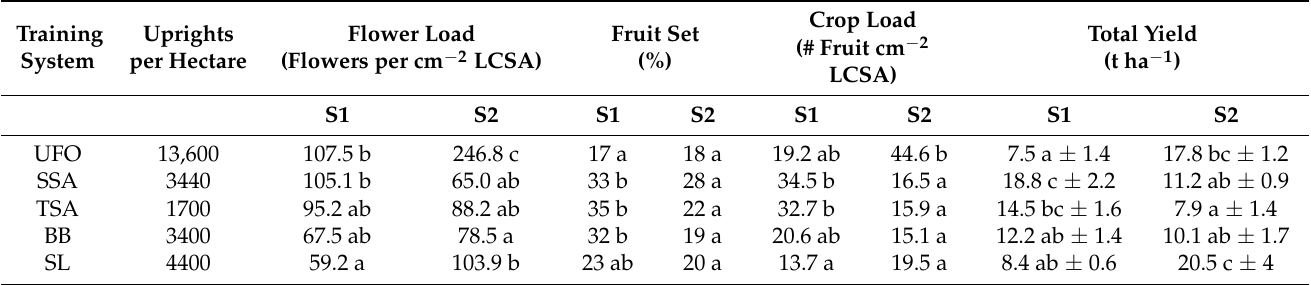
Table 4. Flower load, fruit set, crop load and yields of sweet cherry cv. ‘Kordia’ on multiple training systems for the first (2019–2020) and second (2020–2021) seasons. Letters within columns illustrate significant differences between training systems ( p ≤